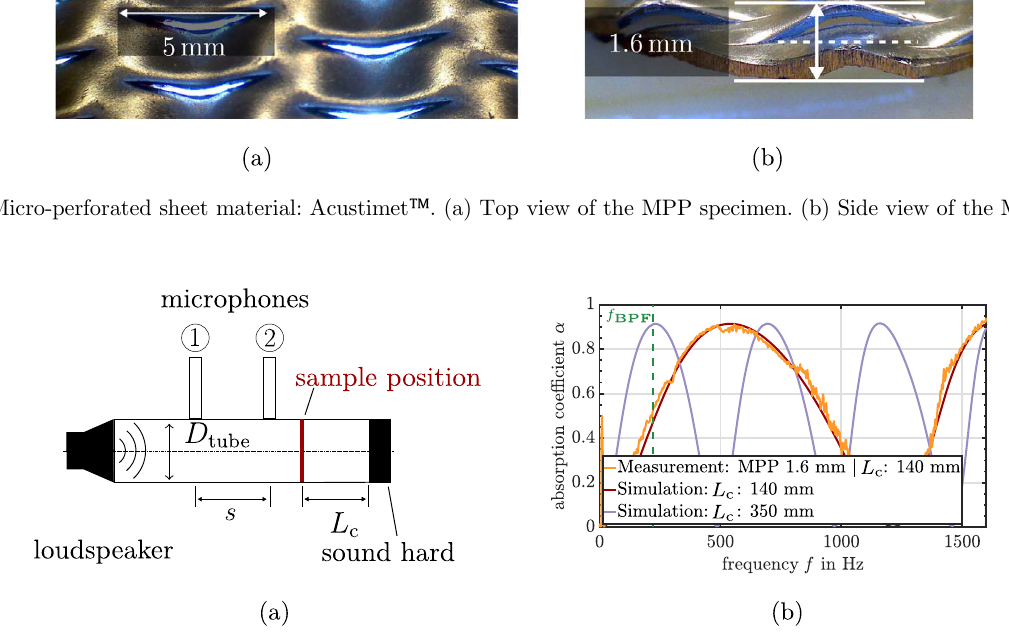
Figure 2. Sheet material parameter characterization. (a) Impedance tube with MPP specimen. (b) Absorption curve of MPP with indicated BPF of the axial fans.